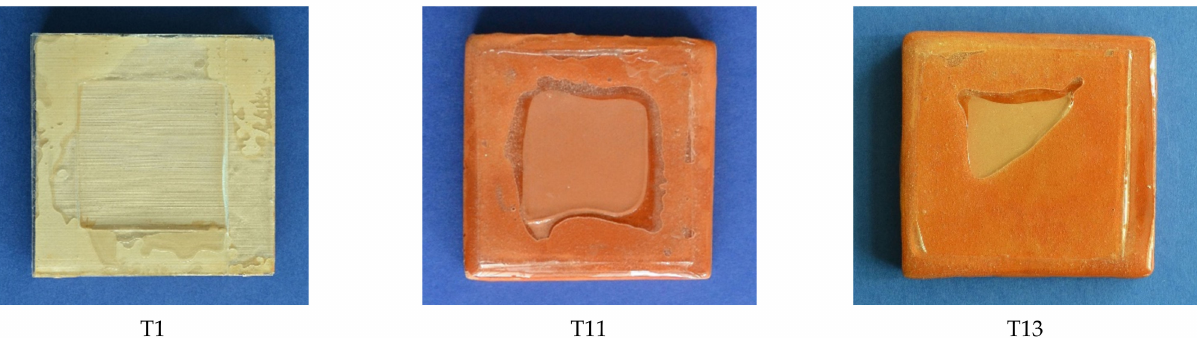
Figure 11. Tile models with artificial